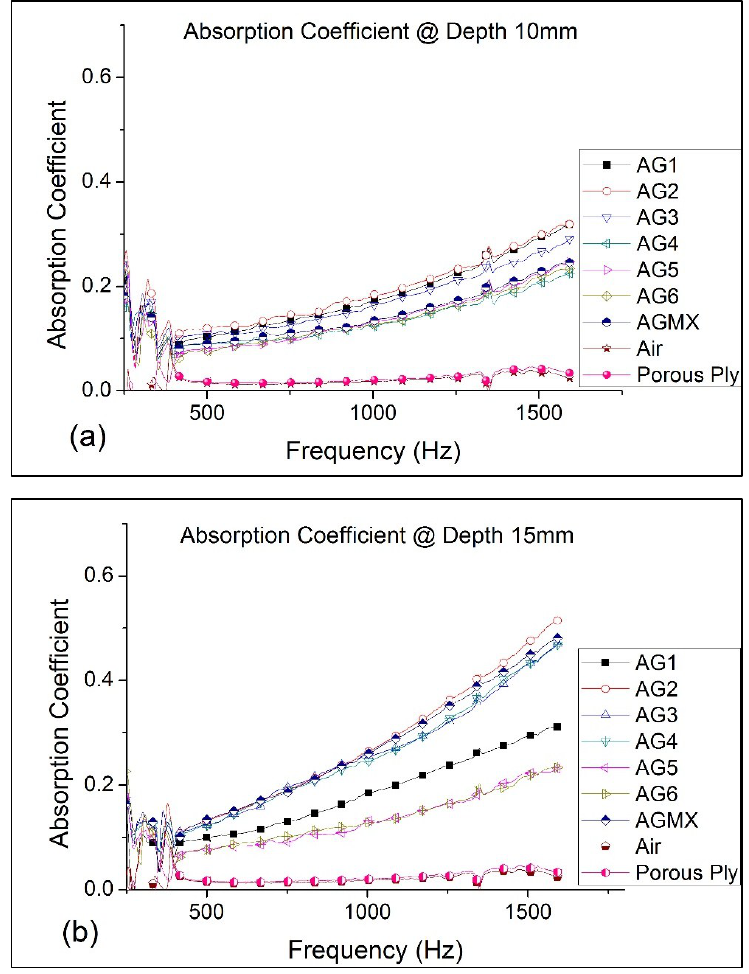
Figure 1. Sound absorption coefficient of silica aerogel (SA) granules ( a ) at 10 mm depth and ( b ) at 15 mm depth. Table 1. Absorption coefficient of SA granules, Air and Porous Ply.